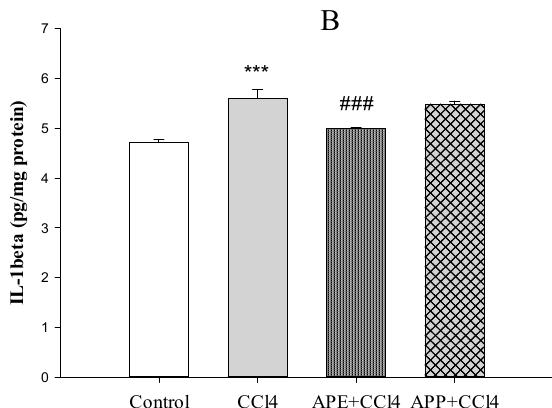
Figure 4. The effects of APE (30 mg/kg, oral), APP (30 mg/kg, oral), and CCl 4 (2 mL/kg; ip once on third day) administration on the TNF- α ( A ) and IL-1 β ( B ) levels in liver tissue in rats. Data are expressed as mean ± SD. *** p < 0.001 compared to the control group, ### p < 0.001, # p < 0.05 compared to the CCl 4 group.